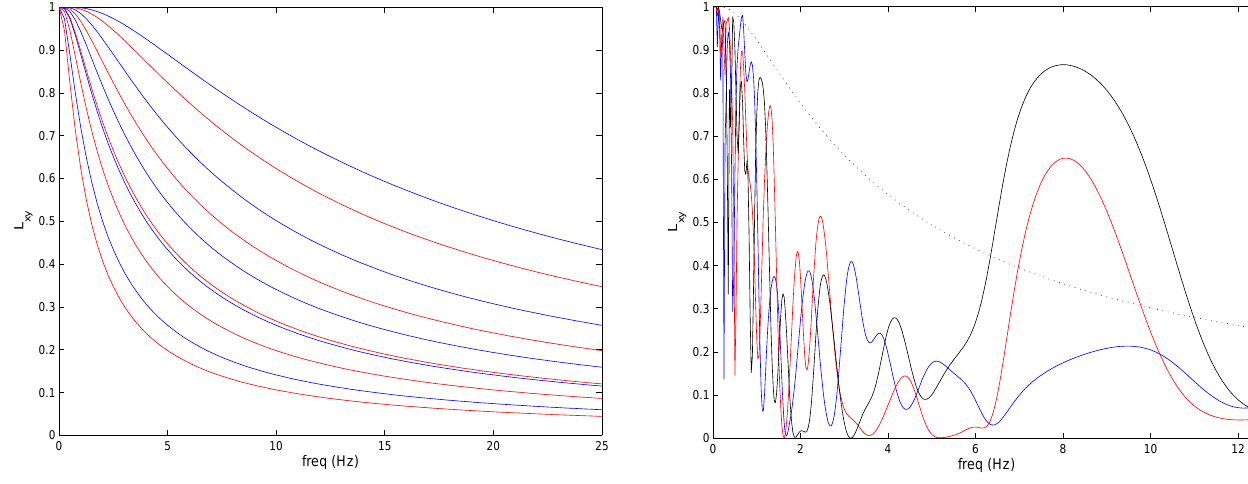
Fig. 5. Wavelet linear coherence L xy of two simulated signals given by Eq. (11) estimated over m = 120 points starting from b = 50 δt (blue), b = 250 δt (red), and b = 450 δt (black). The three WLC curves represent, respectively, the linear relations in the three intervals as in Eq.